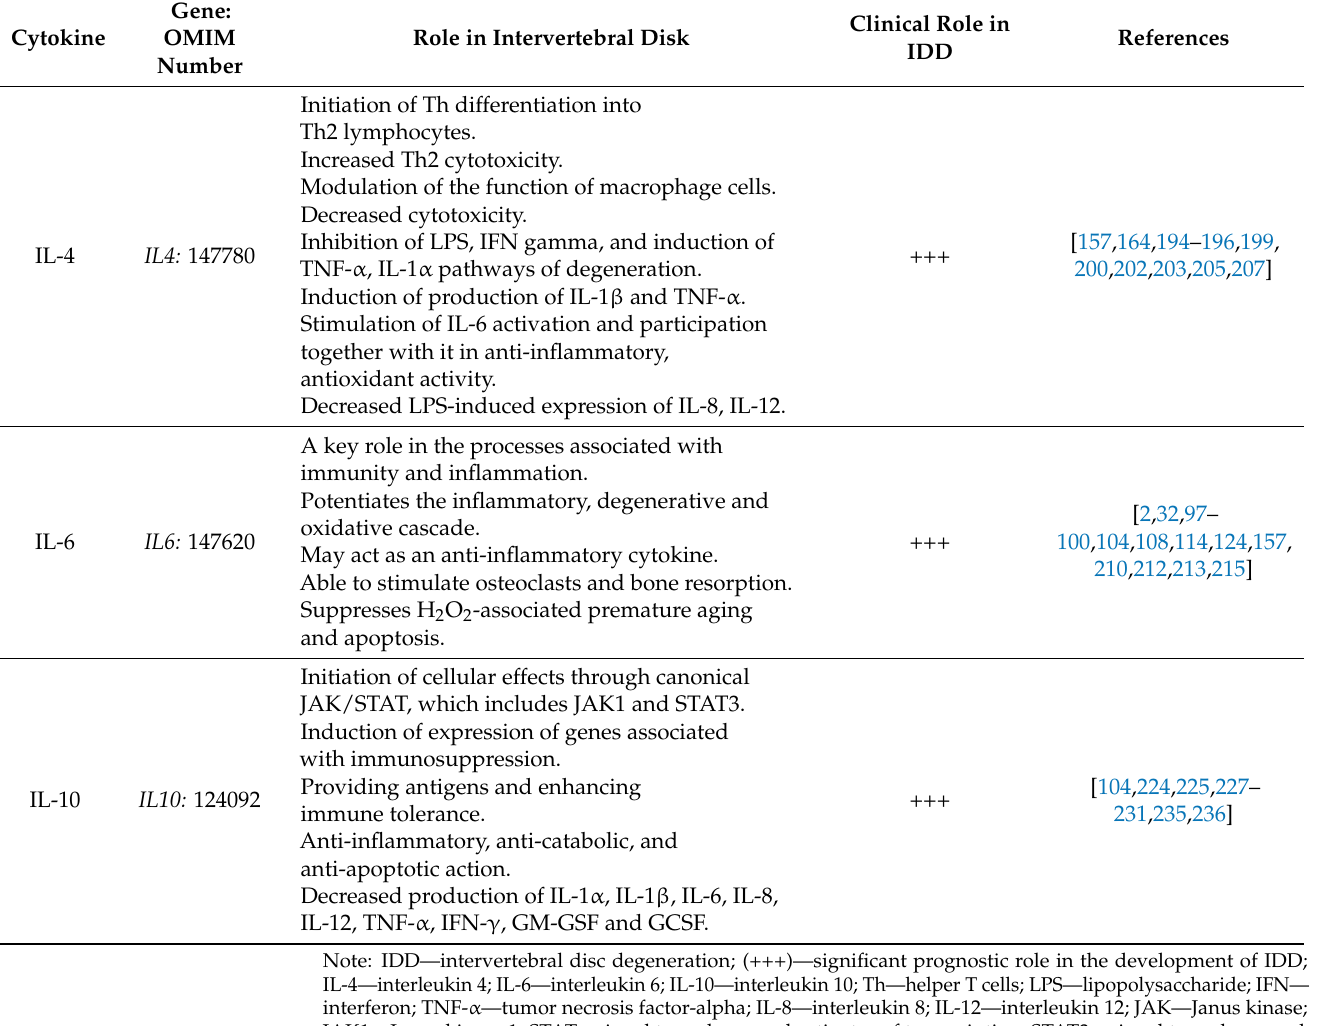
Table 5. Role of anti-inflammatory cytokines in intervertebral disk